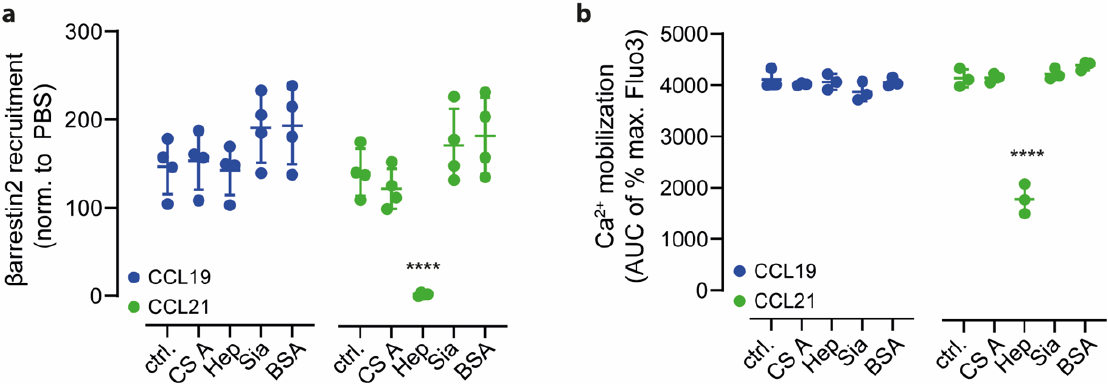
Figure 5. Heparin, but not other glycosaminoglycans, specifically regulate CCL21-mediated signaling. ( a ) Recruitment of β arrestin2-NLuc158 to CCR7-NLuc11 upon stimulation with 1 µ M CCL19 (left) or CCL21 (right) in the presence of PBS (ctrl) or 50 µ g/mL of either chondroitin sulfate A (CS A), heparin (Hep), sialic acid (Sia) or bovine serum albumin as a negative control (BSA). AUC analysis of mean values ± SD of n = 4 is depicted. ( b ) Intracellular calcium mobilization in response to 50 nM of either CCL19 (left) or CCL21 (right) in the presence or absence of indicated ECM proteins. Mean AUC values ± SD of n = 3, statistical analysis: one-way ANOVA with Dunnett correction. Shapiro–Wilk was used as test for normality. **** p ≤ 0.0001.